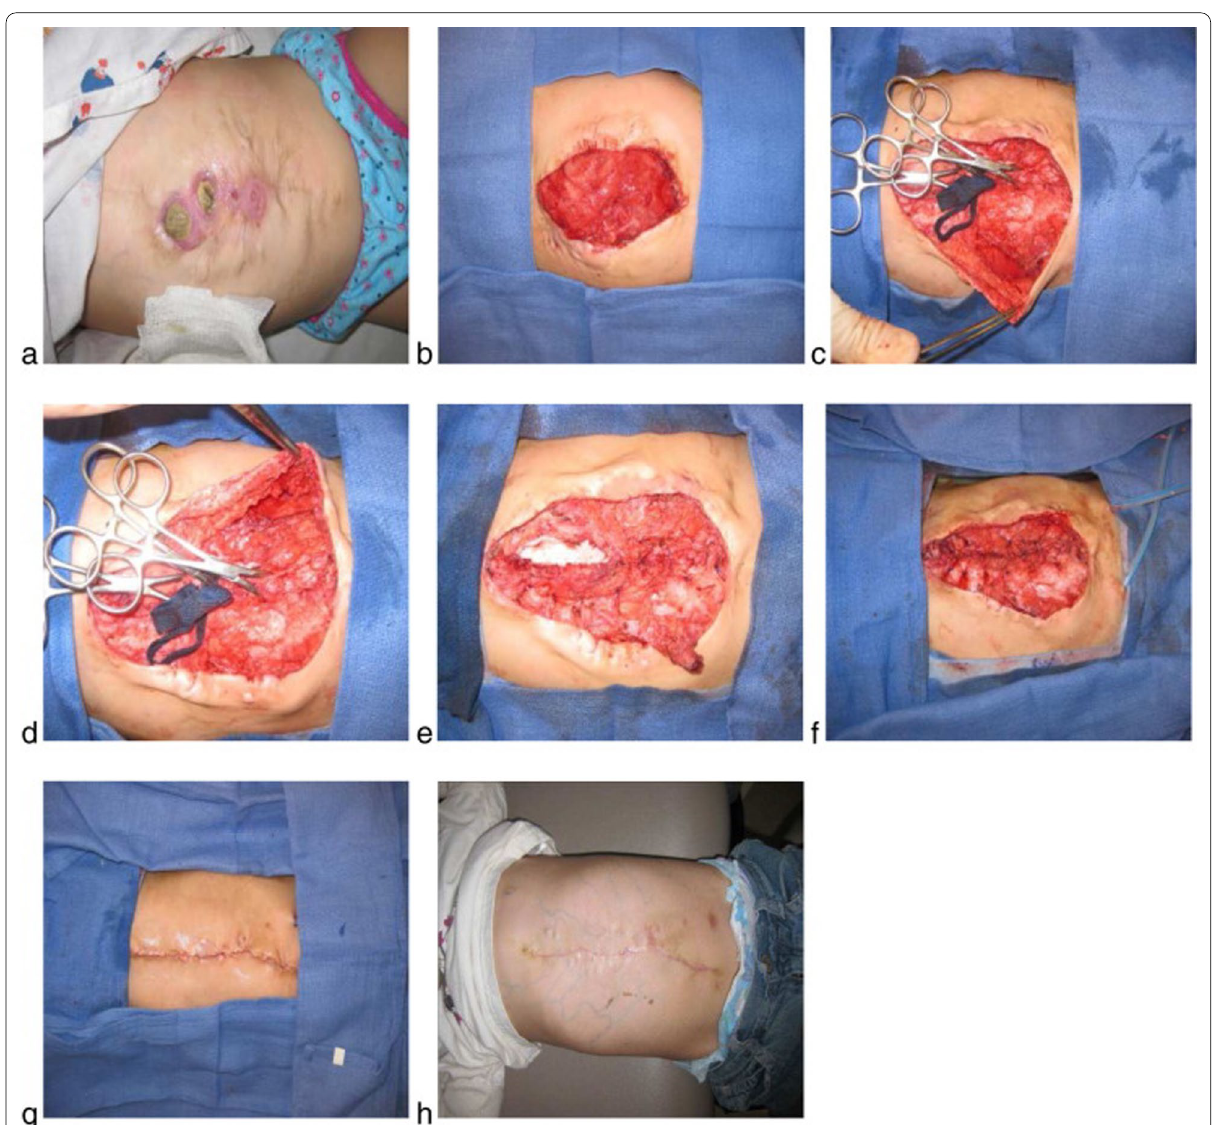
Fig. 8 Case: abdominal reconstruction of gastroschisis, complicated by infection and failure of previous repairs. ( a ) Repair breakdown; ( b ) mesh removal and debridement; ( c ) right component separation; ( d ) left component separation; ( e ) Strattice ® inlay; ( f ) primary fascial closure; ( g ) wound closure; ( h ) 5-month follow-up without evidence of hernia recurrence. Impending extrusion of permanent fascial sutures is evidence, however. ( Adapted from ref. [96], copyright 2017, with permission from the